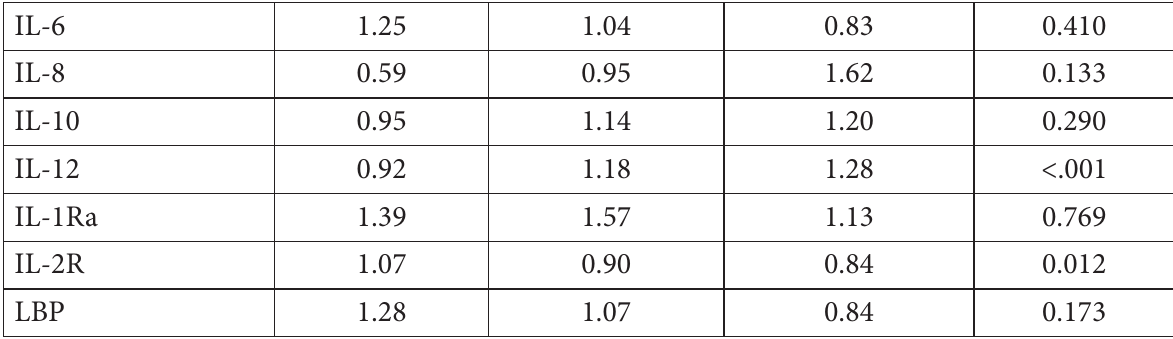
Table 3. Change in plasma markers over 12 weeks of atorvastatin or placebo treatment